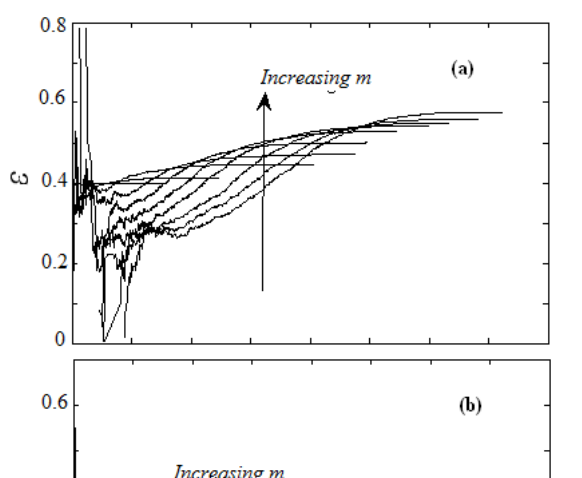
Figure 9. Local slopes of the correlation integrals, for m = 1,..., 10, for (a) Wind speed and (b) Wind power versus r .